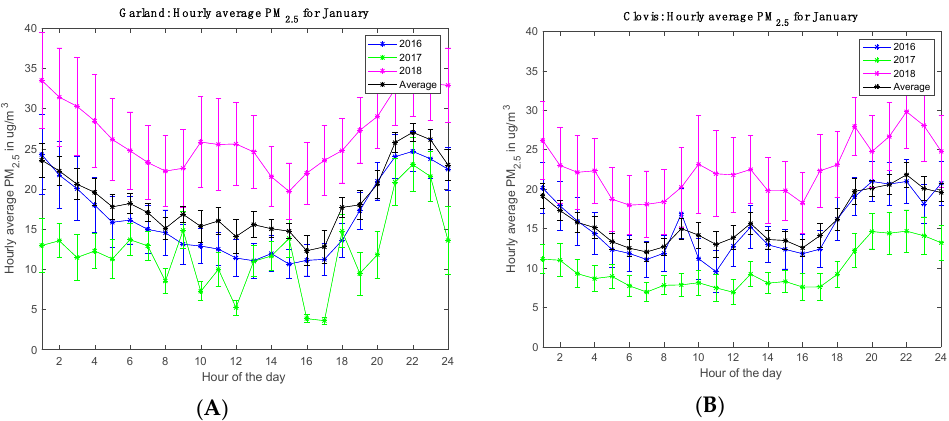
Figure 4. Hourly average PM 2.5 variation for Garland ( A ) and Clovis ( B ) during January.